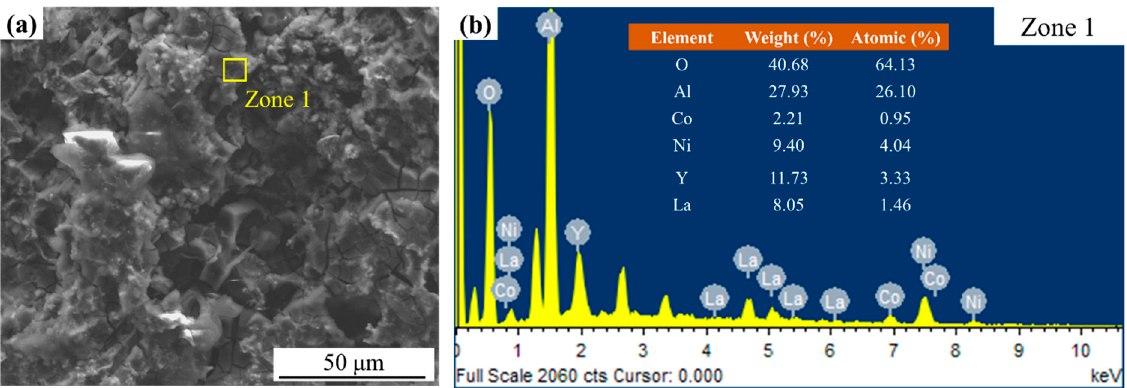
Figure 9. SEM surface ( a ) and cross-sectional ( b ) images of the corroded coated specimens.